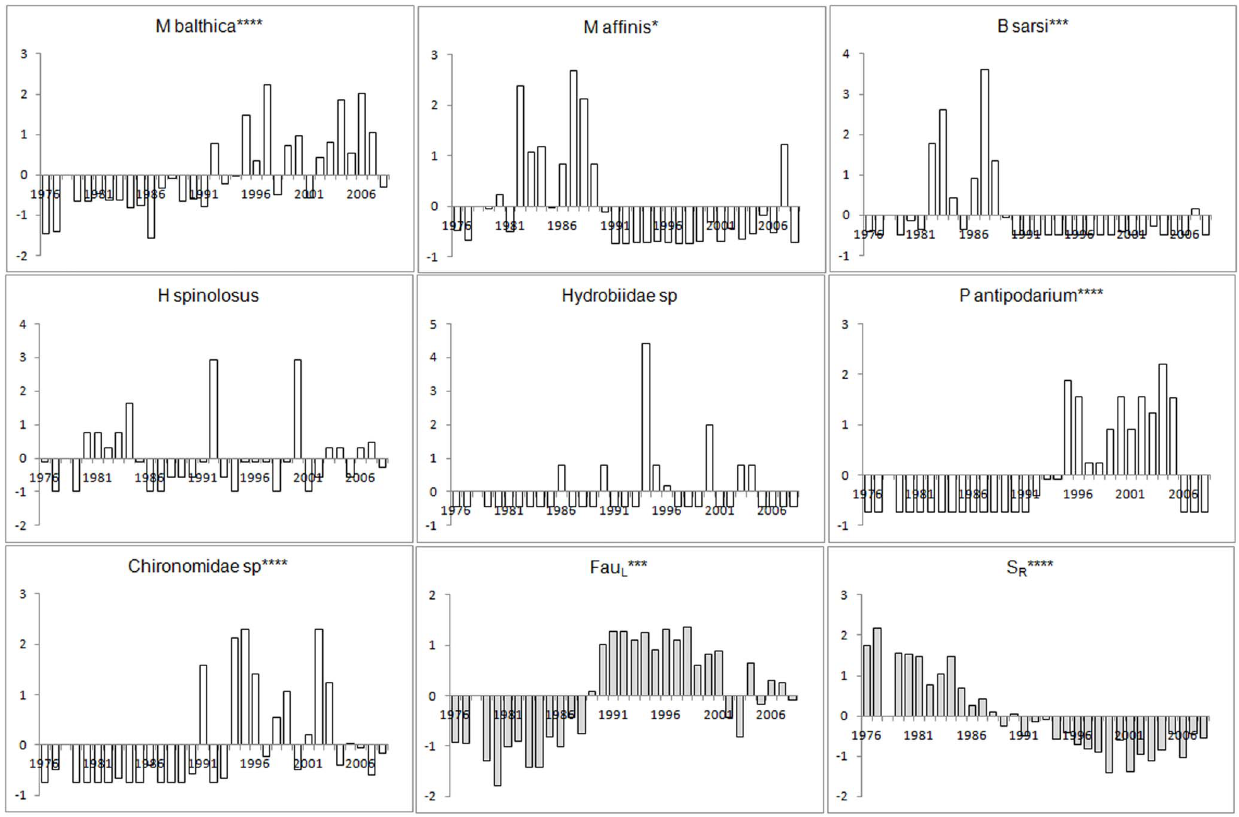
Figure 2. Development of species and variables contributing to temporal change community in community composition in Kva¨do¨fja¨rden. The species presented (white bars) are those exhibiting a multiple metric correlation . 0.2 with any of the first two ordination-axes of the PCO-analysis for each data set and the variables (grey bars) associated with community development according to the DISTLM analyses. The annual value of each species and variable is presented as the standardised deviation from the average value during the whole time-series. For abbreviations of species names and environmental variables see table 1 and 2 respectively. * denotes a significant linear trend at a =0.05, *** a =0.001 and **** a